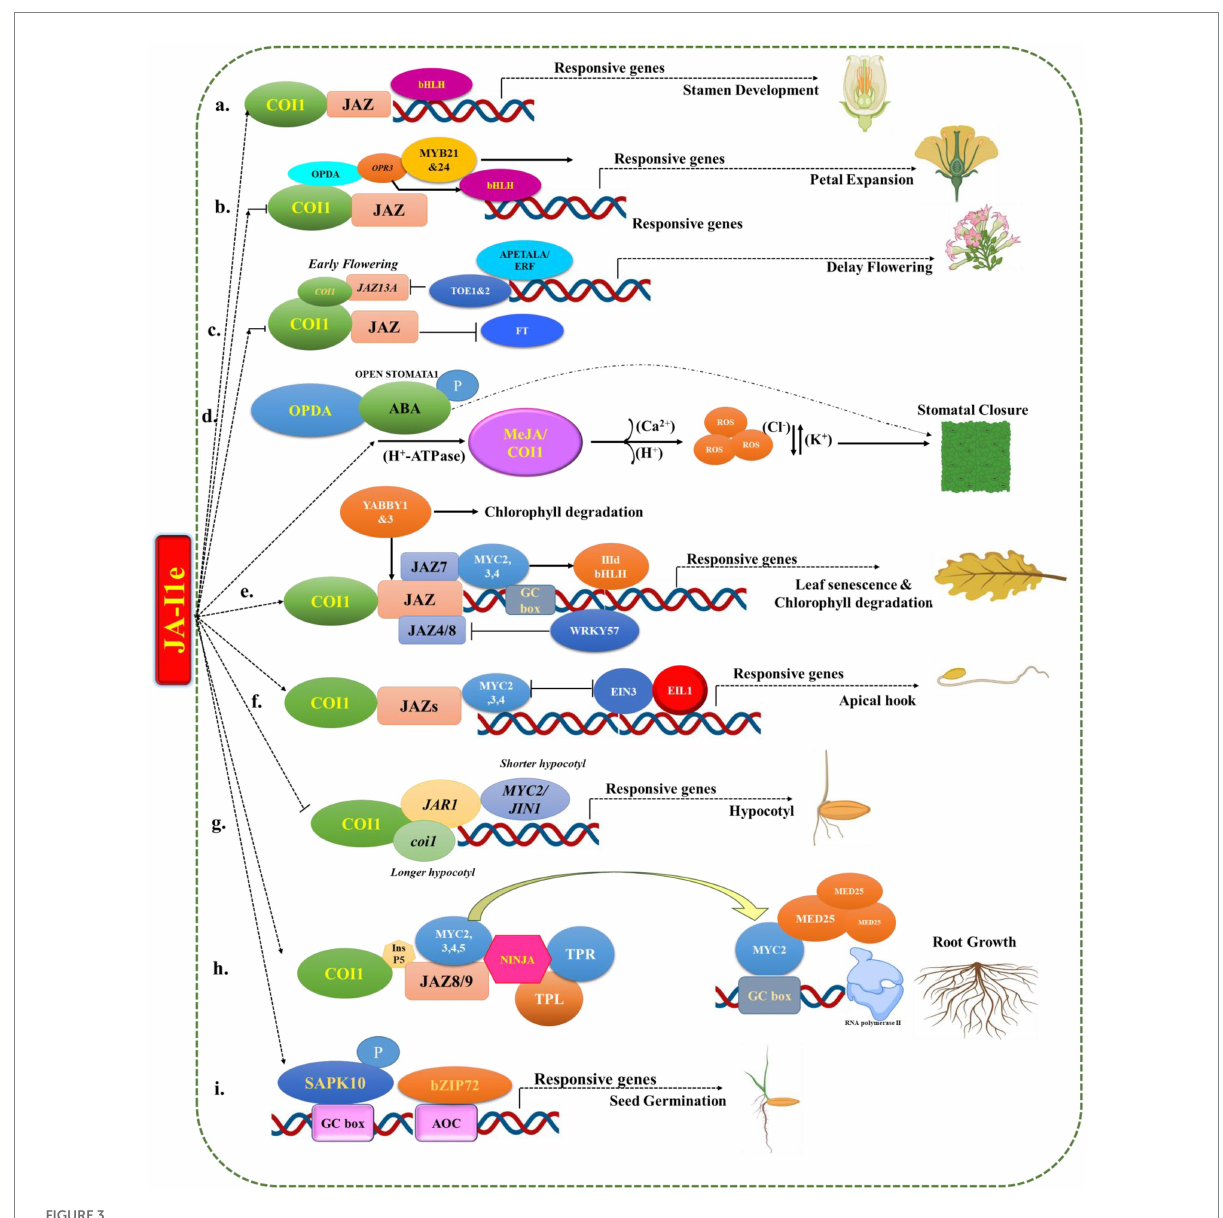
FIGURE 3 Schematic diagram for role of jasmonates in the plant growth and